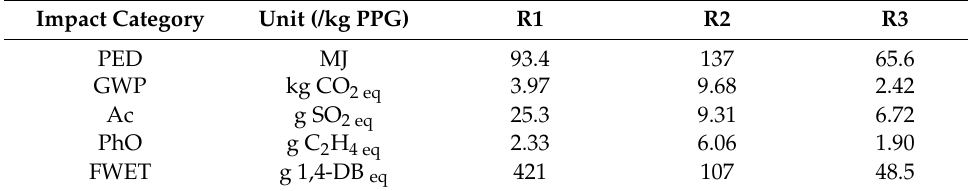
Table 2. Environmental PPG processing routes’